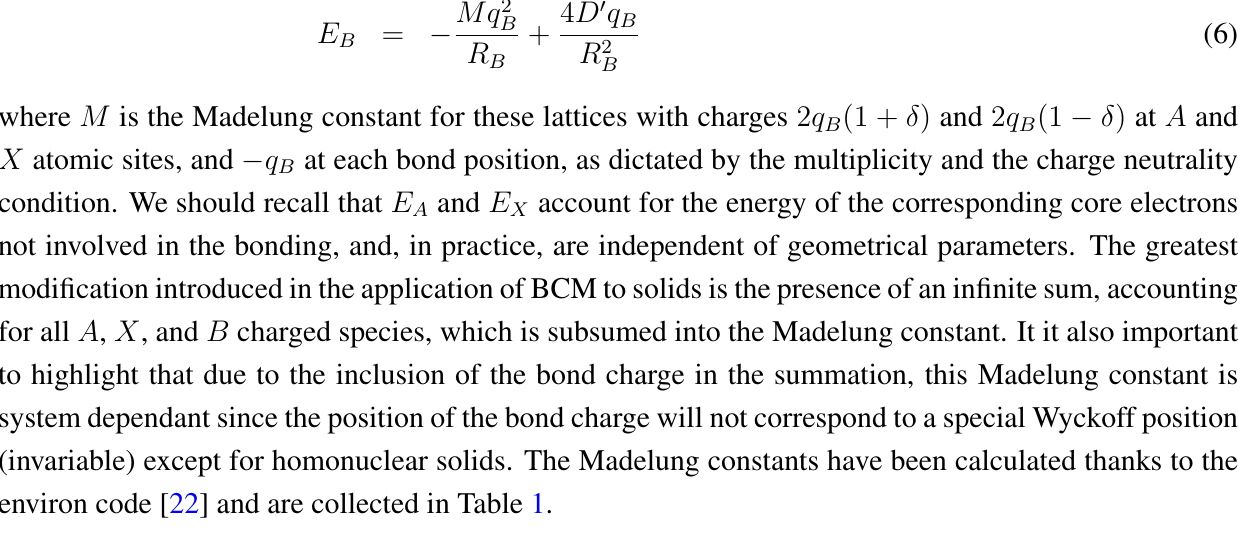
=r and 1 2 and 1